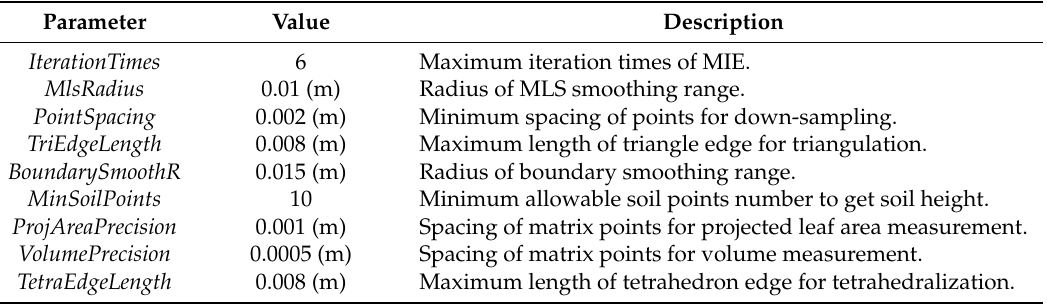
Table 2. Descriptions and values of the key parameters used by our methods.